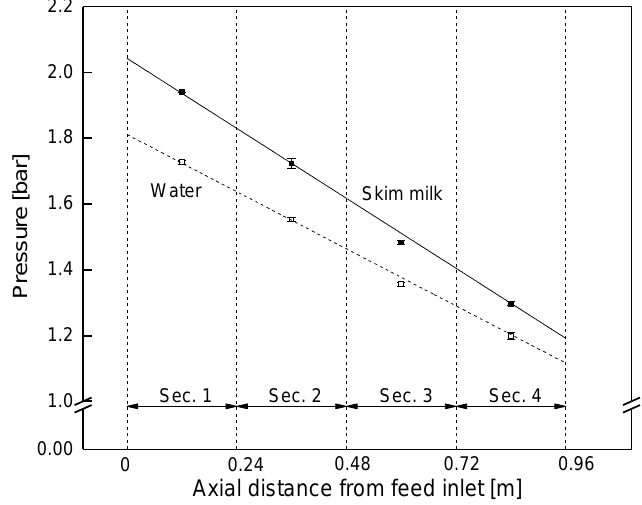
Figure 10. Pressure drop in the sectioned SWM (length of 0.96 m) at a mean crossflow velocity of 0.42 m s − 1 .